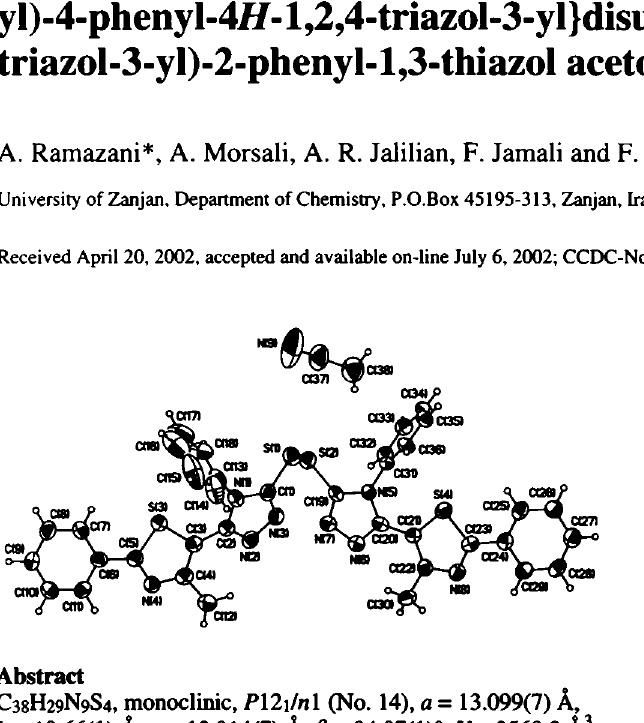
Table 1. Data collection and handling.